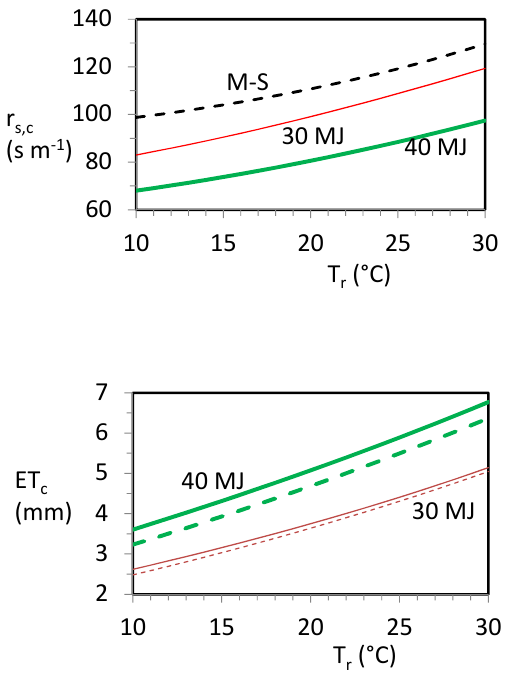
Figure 3. Variation of crop surface resistance r s , c (a) and daily stan- Fig. 3- Variation of crop surface resistance r s,c (a) and daily standard evapotranspiration ET c (b) as a 5 dard evapotranspiration ET c (b) as a function of air temperature for function of air temperature for two different values of extraterrestrial solar radiation ( R a ) expressed in 6 two different values of extraterrestrial solar radiation ( R a ) expressed MJ m -2 d -1 (30 and 40) and comparison with the Matt-Shuttleworth estimate (M-S) (dotted line) for a 7 in MJm − 2 day − 1 (30 and 40) and comparison with the Matt– crop with K c = 1 and z h =1 m, under a sub-humid climate with u r = 2 m s -1 . 8 Shuttleworth estimate (M–S) (dotted line) for a crop with K c = 1 and z h = 1m, under a sub-humid climate with u r = 2ms − 1